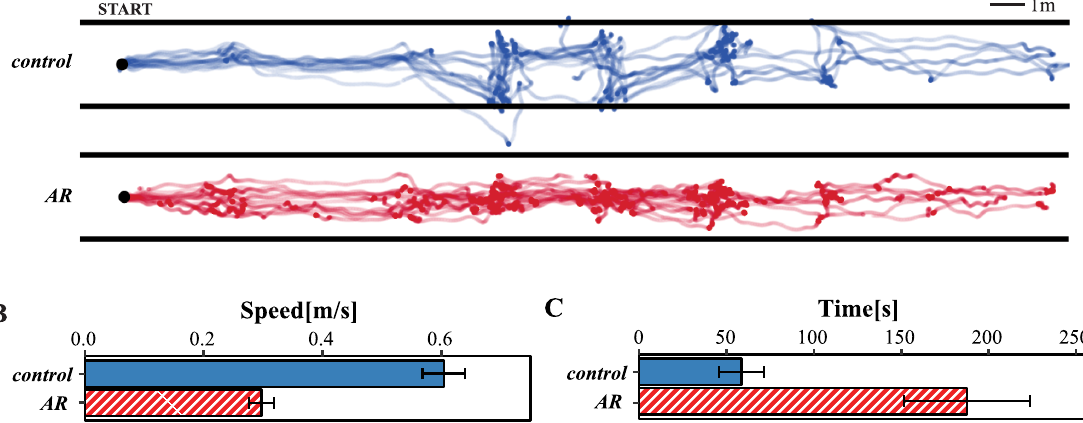
Fig 3. Path analysis. (A) Lines show estimated paths taken by users in the control (blue) and AR (red) groups. The width of the hallway is illustrated for each group with two horizontal lines. Note that paths outside of the hallway suggest errors either in motion tracking or path alignment. (B, C) Bars show mean and standard error for walking speed and time to complete task. Note that walking speed excludes stationary